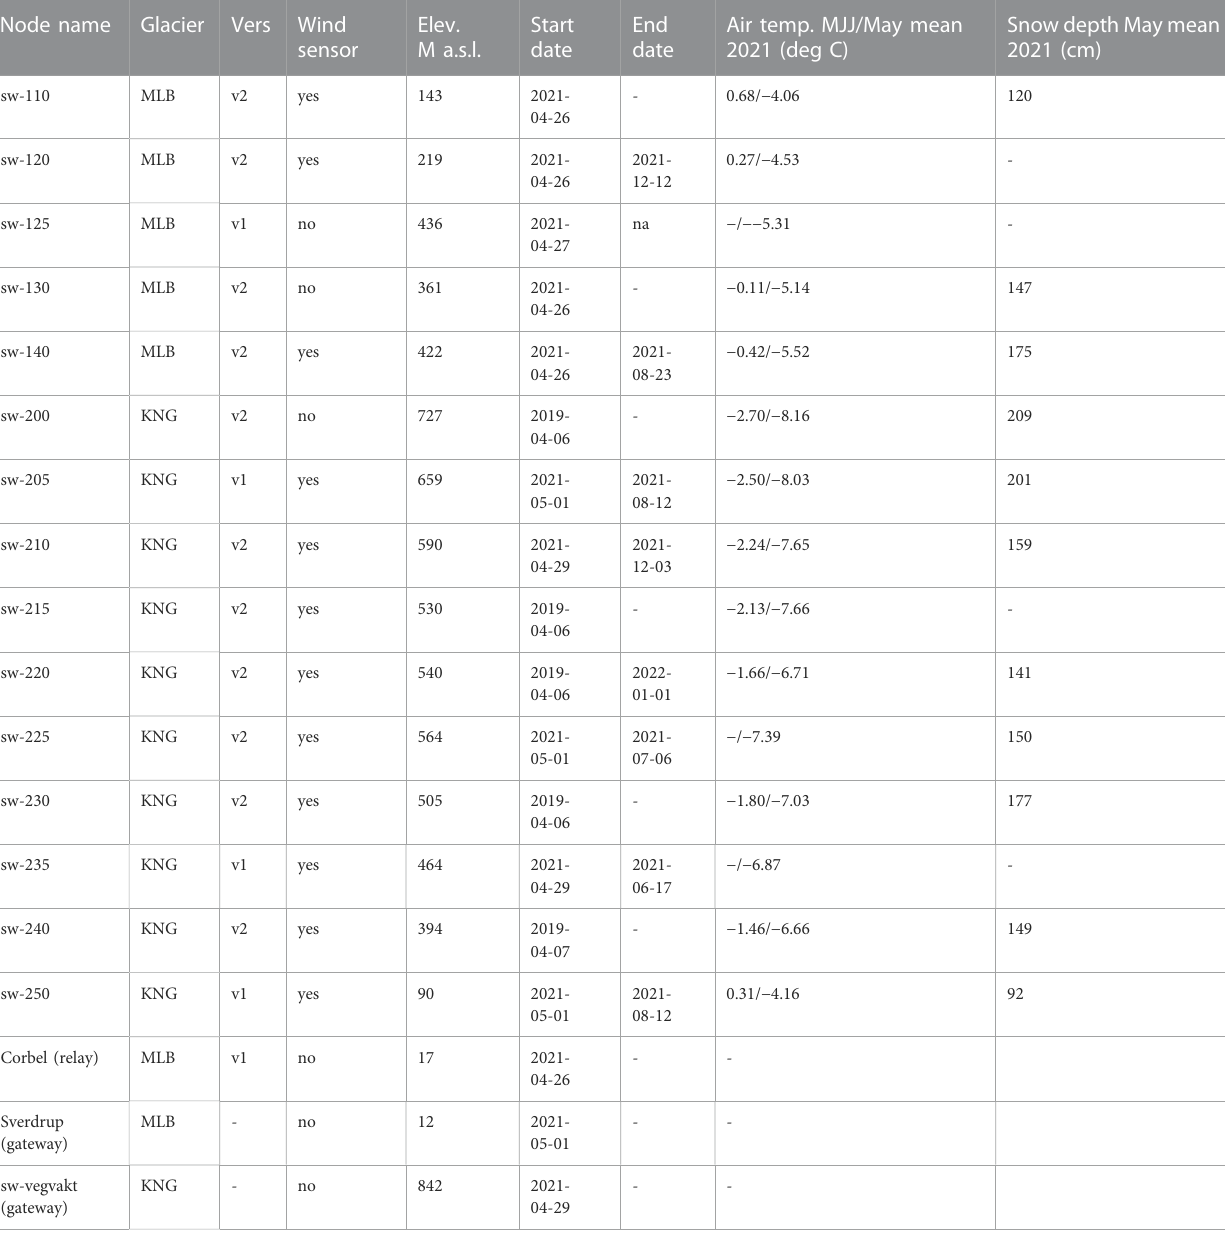
TABLE3SummaryofnodesdeployedintheregionofNyÅlesund.MLBcorrespondstoMidtreLovénbreenglacierandKNGtoKongsvegenglacier.Twoaverageair temperatures are included, when available. First MJJ includes data from May, June, and July, followed by the average for May